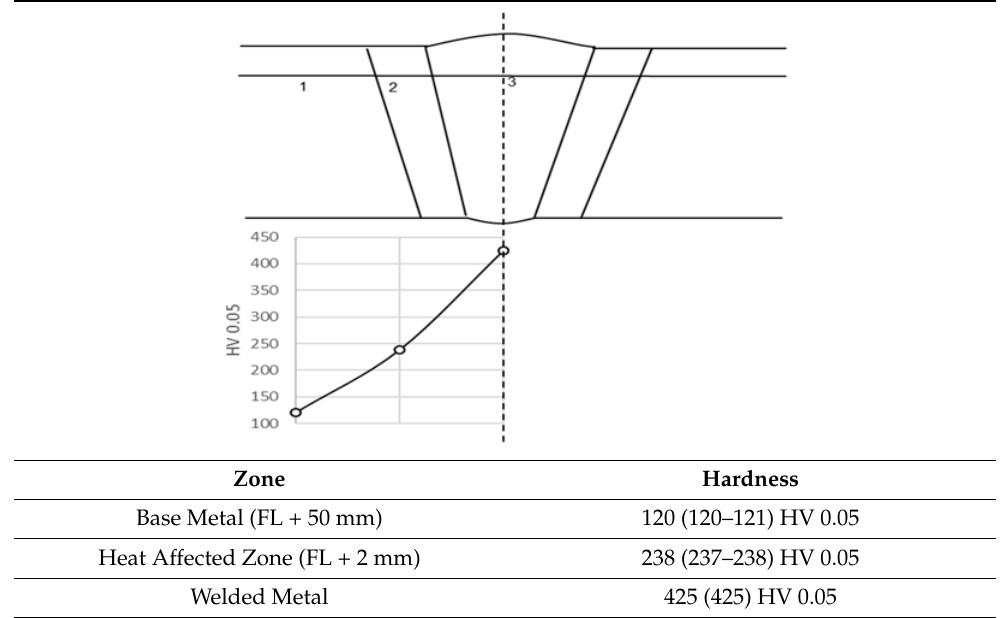
Table 4. Hardness results and scheme.